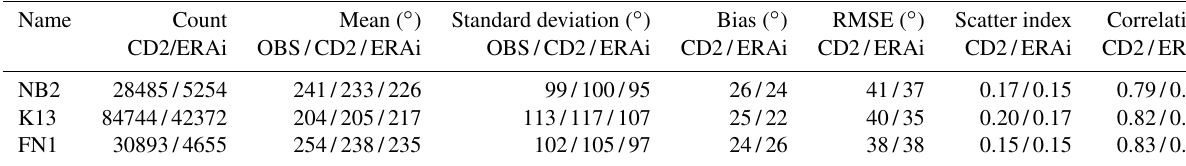
Table 5. Error metrics for the mean wave direction at three locations derived from in situ observations (OBS), coastDat2 hindcast (CD2) and